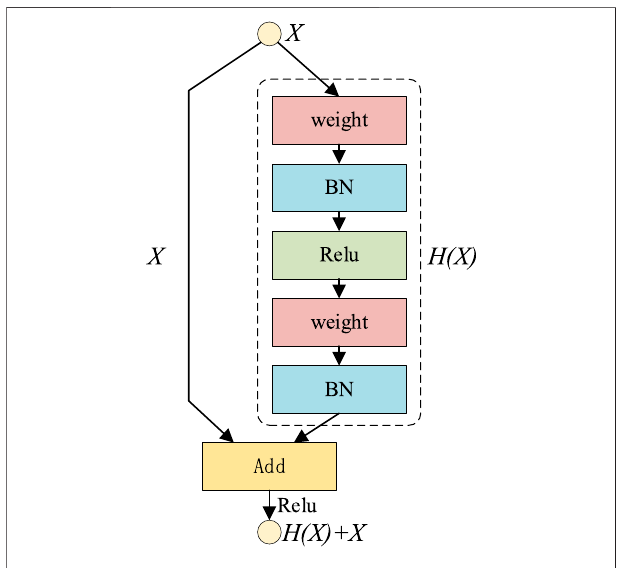
FIGURE 4 | Residual